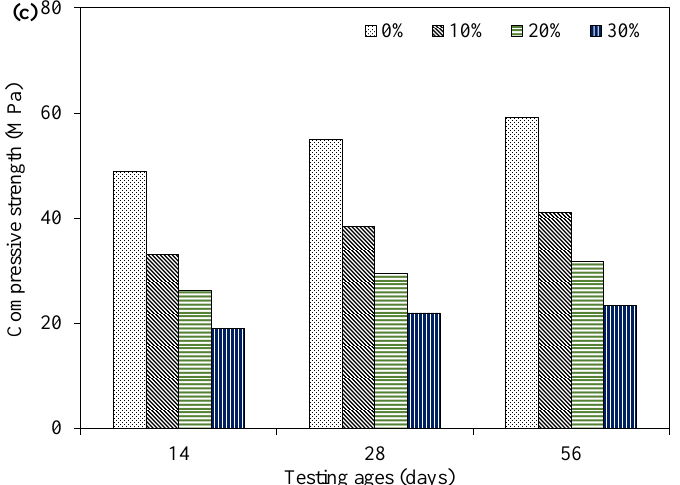
Figure 9. Compressive strength results for specimens incorporating various dosages of rubber: ( a ) R1 ( b ) R5 ( c ) R10.